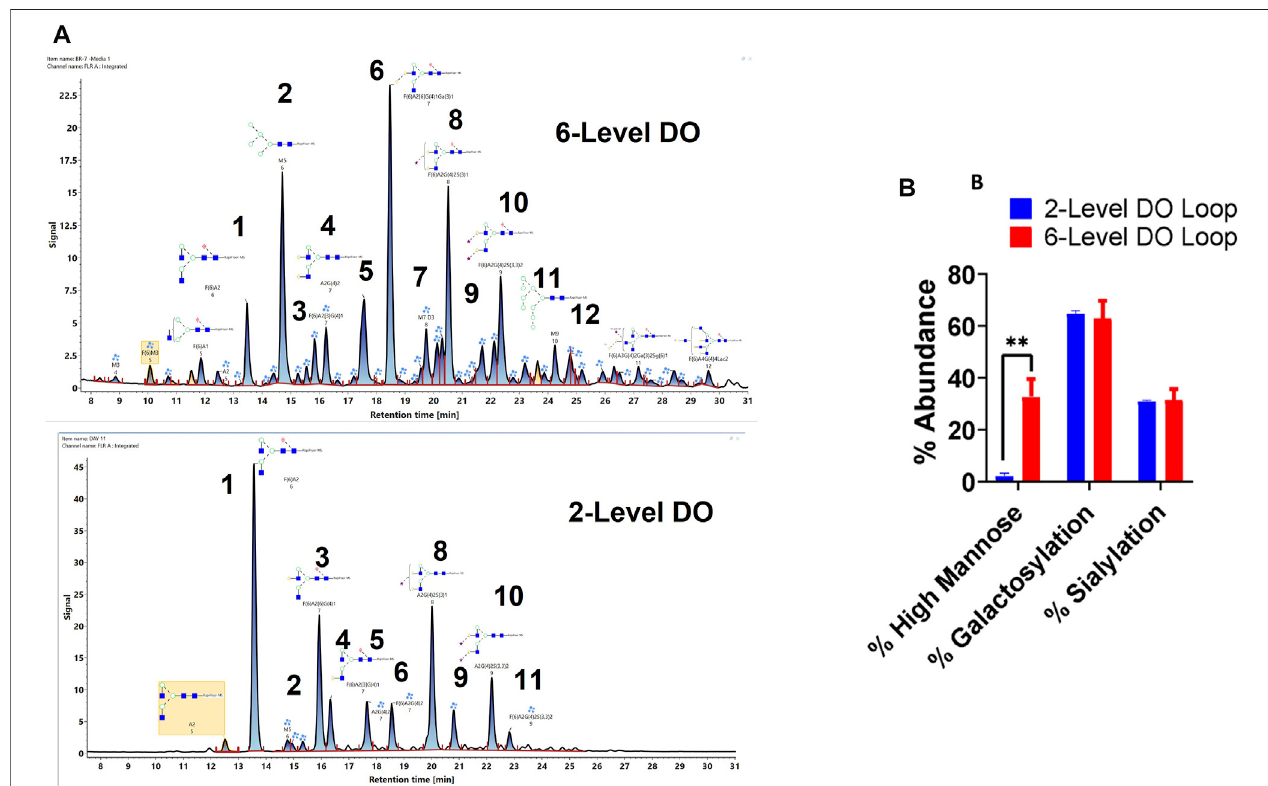
FIGURE 6 | (A) Released glycan map (FLR trace) of the VRC01 expressed using A11 clone using two different processes in Ambr 250 bioreactor. (B) Relative abundance of various glycan attributes of VRC01 grown under the two process conditions.